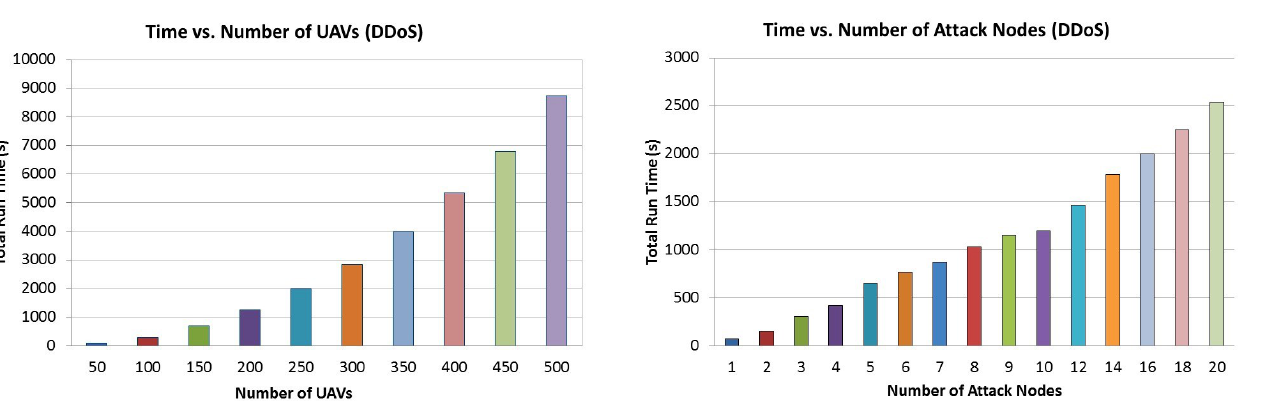
Figure 2. Run time variation with increasing number of UAVs for DDoS attack (same frequency of all hosts)